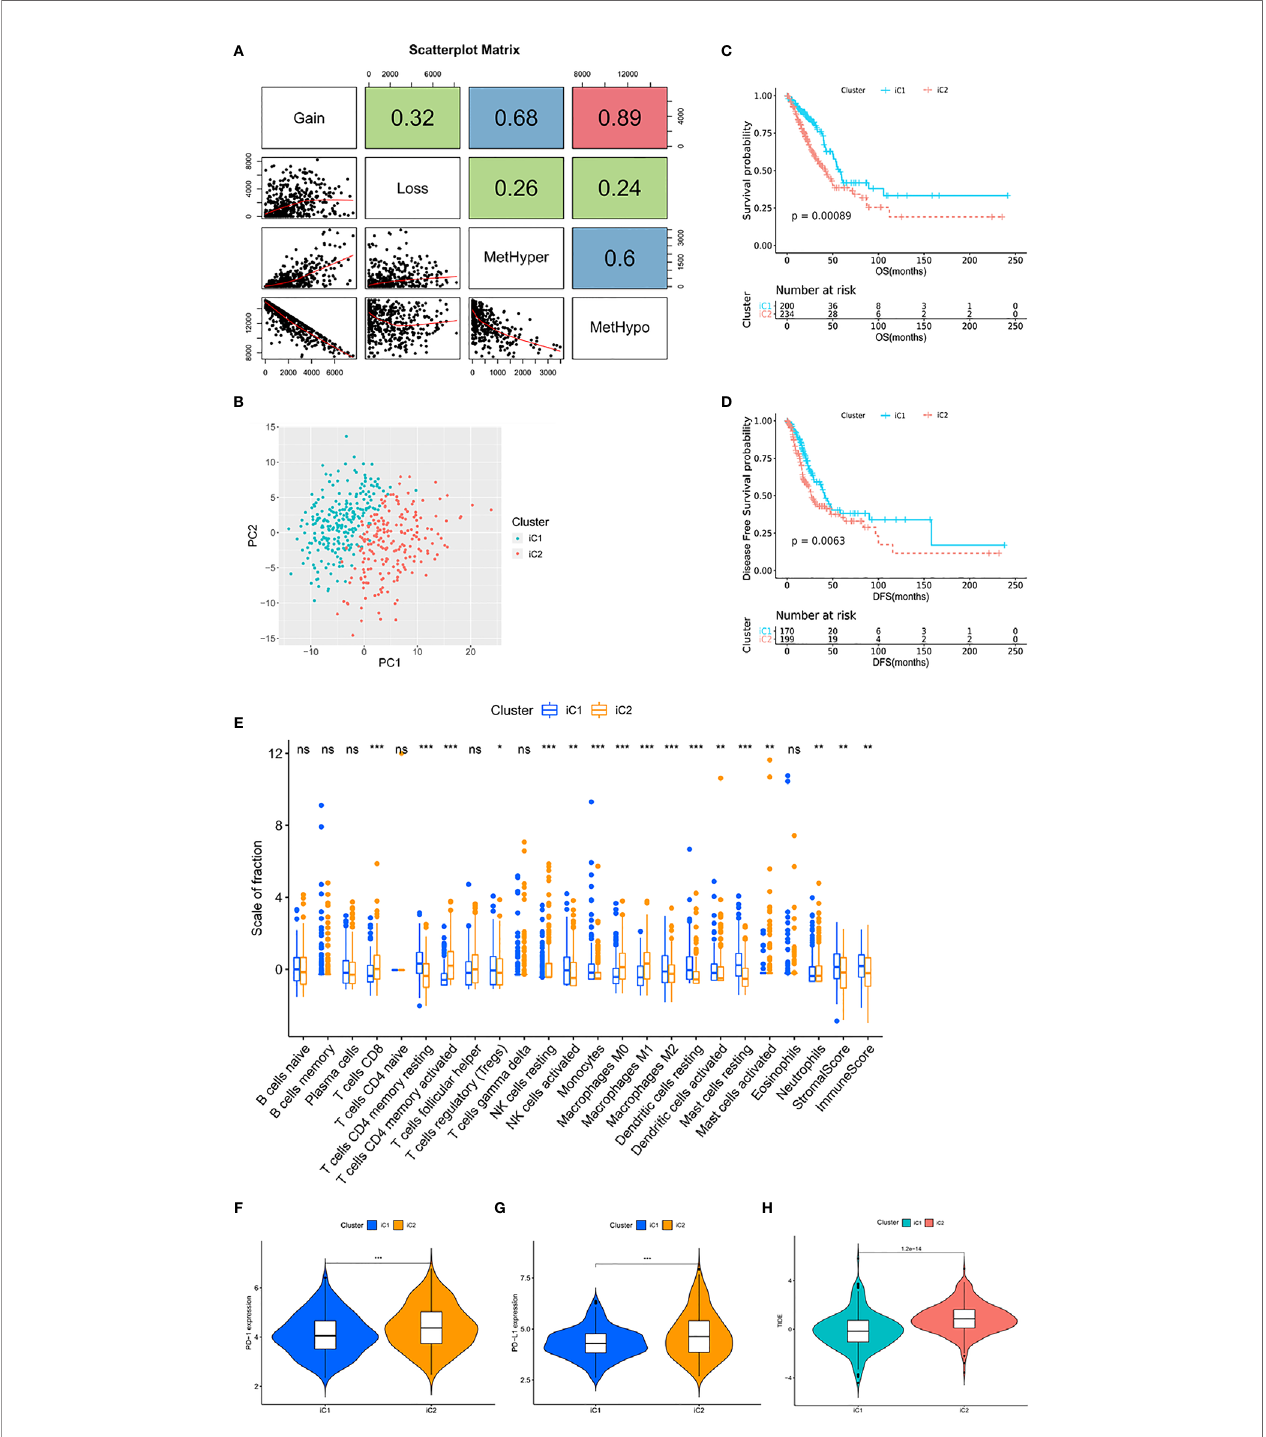
FIGURE 2 | Multi-omics data identi fi ed molecular subtypes with distinct TIME. (A) Scatter distribution of MetHyper/MetHypo/gain/loss frequencies from samples. The number in the box represents the correlation coef fi cient of the corresponding position; each dot represents a sample. The Spearman method was used to calculate the correlation; p < 0.001. (B) The PCA of the two molecular subtypes. The green dots represent the patients in iC1 (n = 203). The red dots represent the patients in iC2 (n = 240). (C) Survival analysis with the Kaplan – Meier curve showed that the OS rate in iC1 was signi fi cantly higher than that in iC2 (p < 0.001); (D) the DFS rate in iC1 was signi fi cantly higher than that in iC2 (p = 0.0063). Signi fi cance was determined using the log-rank p test. (E) The fractions of 22 immune cell types, stromal score, and immune score in iC1 and iC2. (F, G) Expression level of (F) PD-1 and (G) PD-L1 in iC subtypes. (H) TIDE score in iC subtypes. *p < 0.05, **p < 0.01, and ***p < 0.001. ns, not statistically signi fi